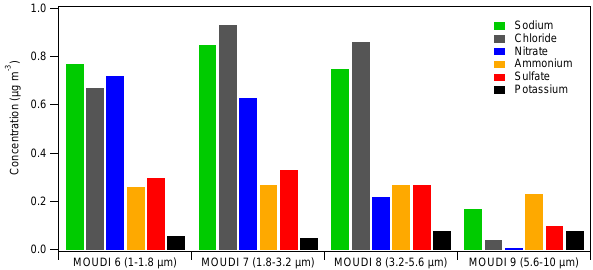
Fig. 6. Concentrations of sodium, chloride, nitrate, ammonium, sulfate and potassium in the four size ranges obtained by the IC measurements from the MOUDI sample that was collected between 15:15 and 17:00 during the episode on 25